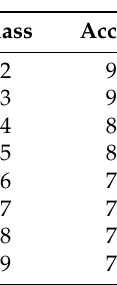
Table 4. The prediction accuracy of long cycle maintenance time.